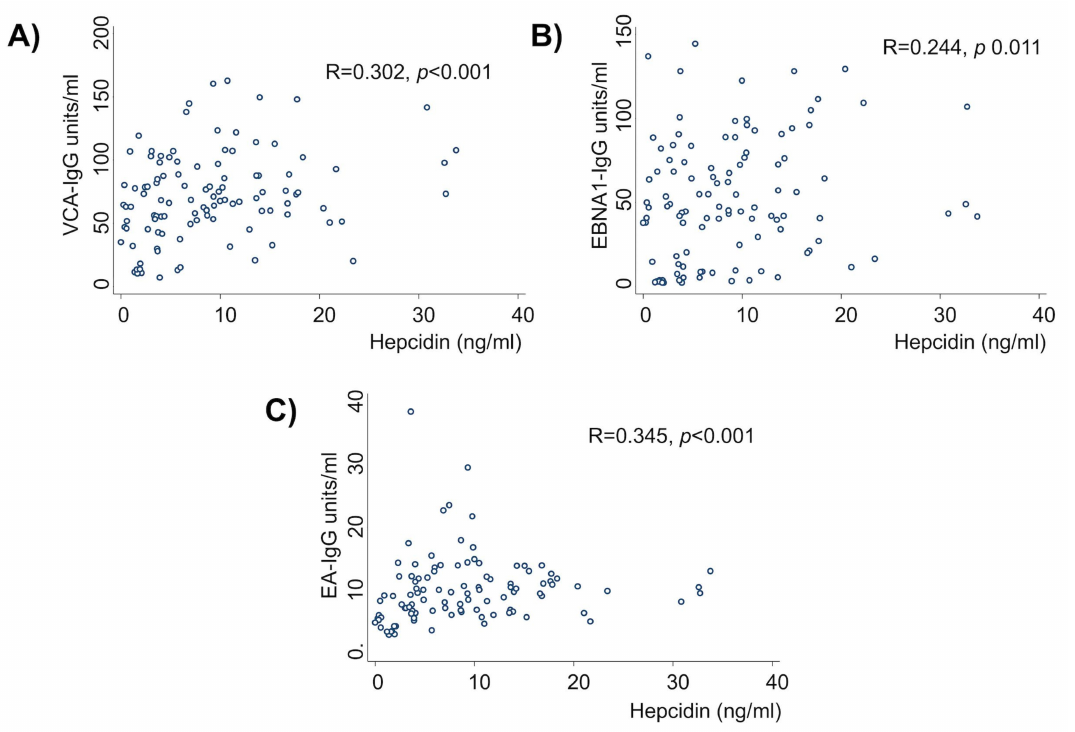
Figure 2. Hepcidin concentration positively correlates with the levels of EBV antibodies. ( A ) Viral capsid antigen (VCA), ( B ) EBV nuclear antigen 1 (EBNA1), and ( C ) early antigen (EA, also known as BMRF1) antibodies have a positive correlation with increased concentrations of